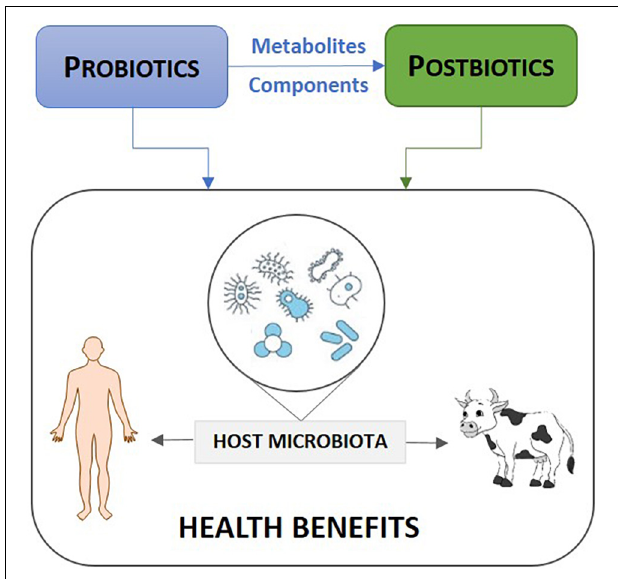
FIGURE 1 | Use of probiotics and postbiotics to manage animal and human